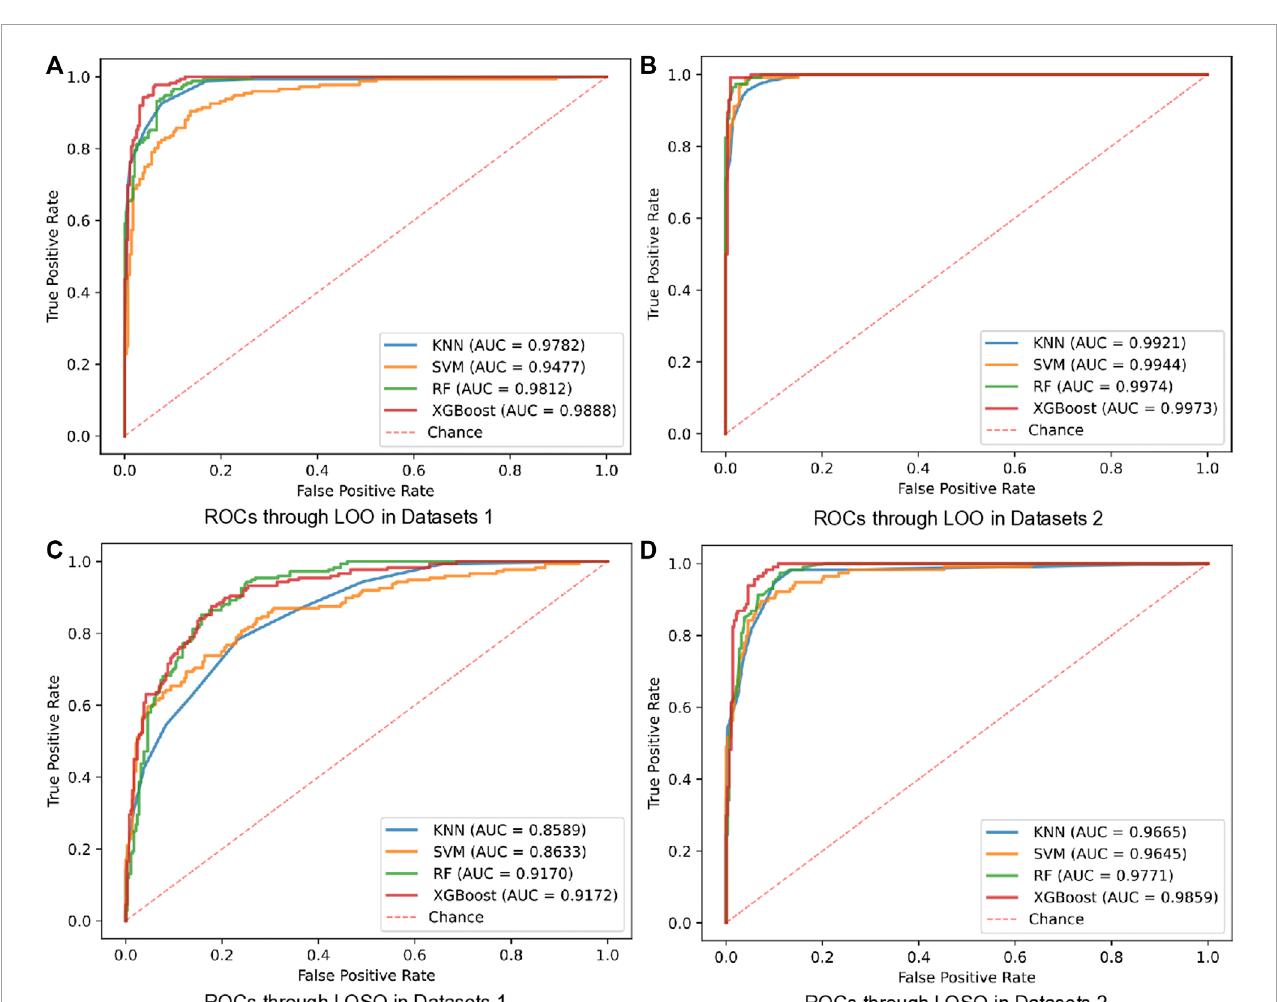
FIGURE 5 ROCs of LOO and LOSO for HF diagnostics over 2 datasets using 4 classifiers. (A) ROCs through LOO in Datasets 1. (B) ROCs through LOO in Datasets 2. (C) ROCs through LOSO in Datasets 1. (D) ROCs through LOSO in Datasets 2.